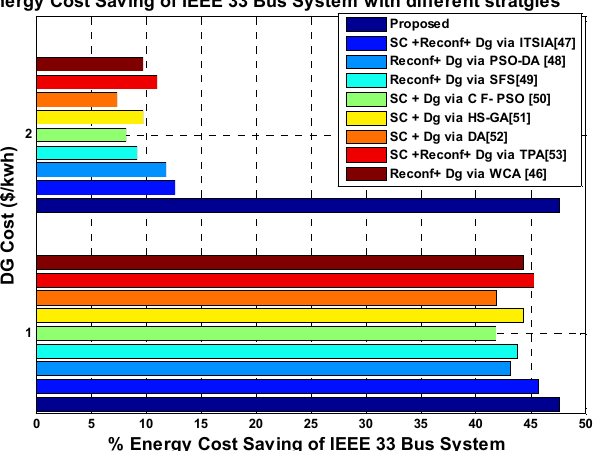
Figure 6. Comparison of % energy savings for the IEEE 33 system with different strategies of energy saving.